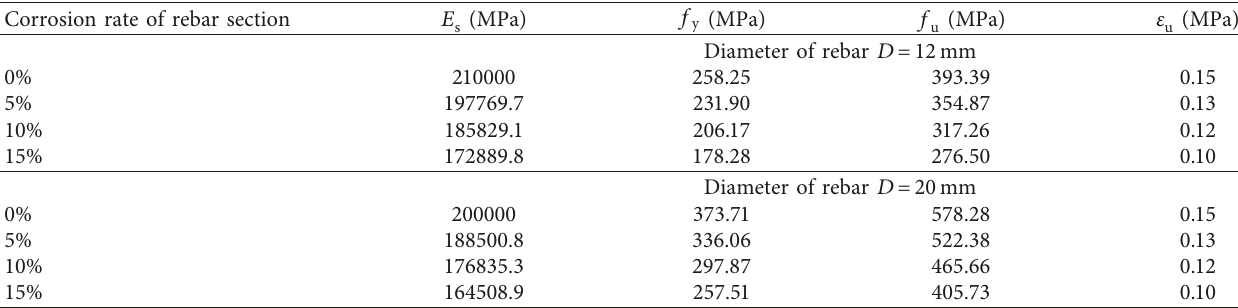
Table 6: Mechanical parameters of corroded rebars.